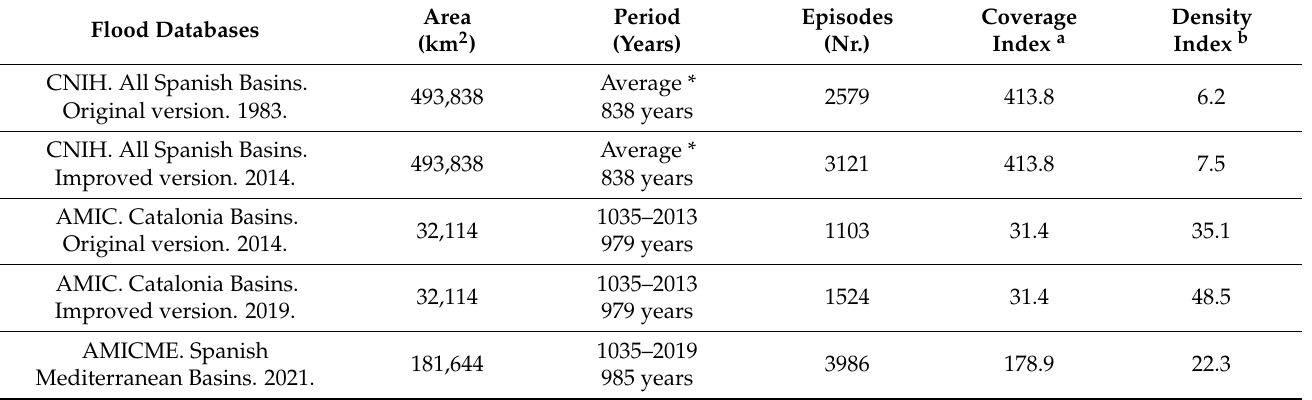
Table 1. Coverage and Density Indices for different Spanish flood databases. Updated after Barrien- dos et al.,